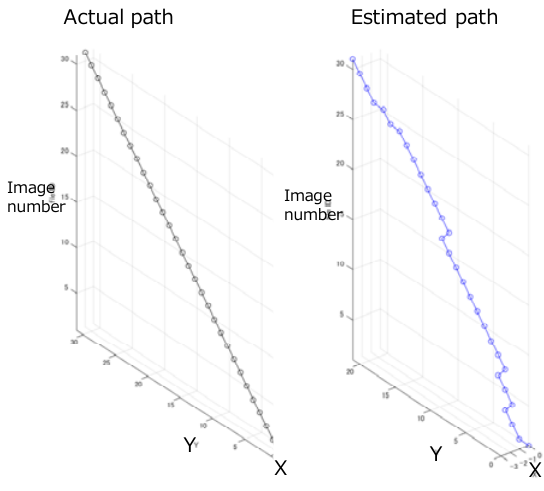
Figure 10. Camera network data, Elevator hall (Left image: estimated camera path, center image: 4-neighbor network, right image: 8-neighbor